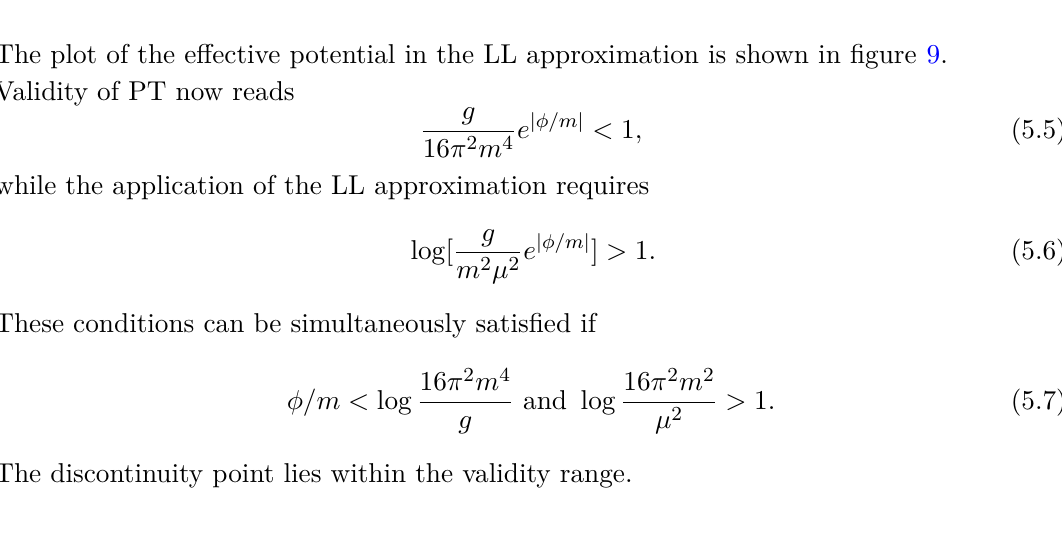
Figure 9 . Effective potential for the exponential case. The blue line is the LL numerical solution, the red dashed line is the classical